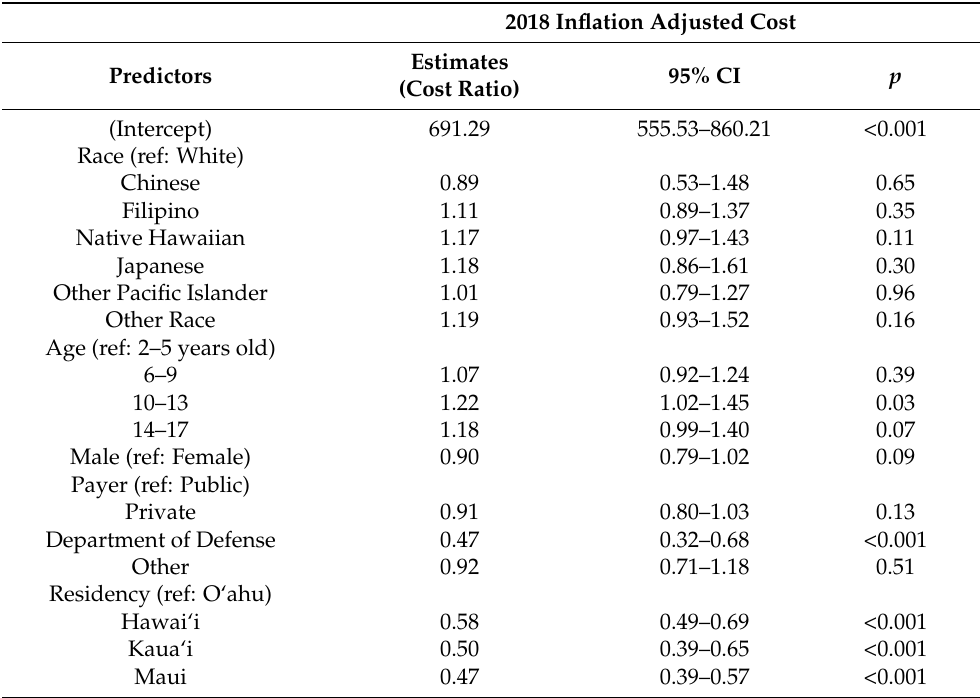
Table 5. Multivariable generalized linear model with gamma distribution, log link function, and robust standard error estimation a